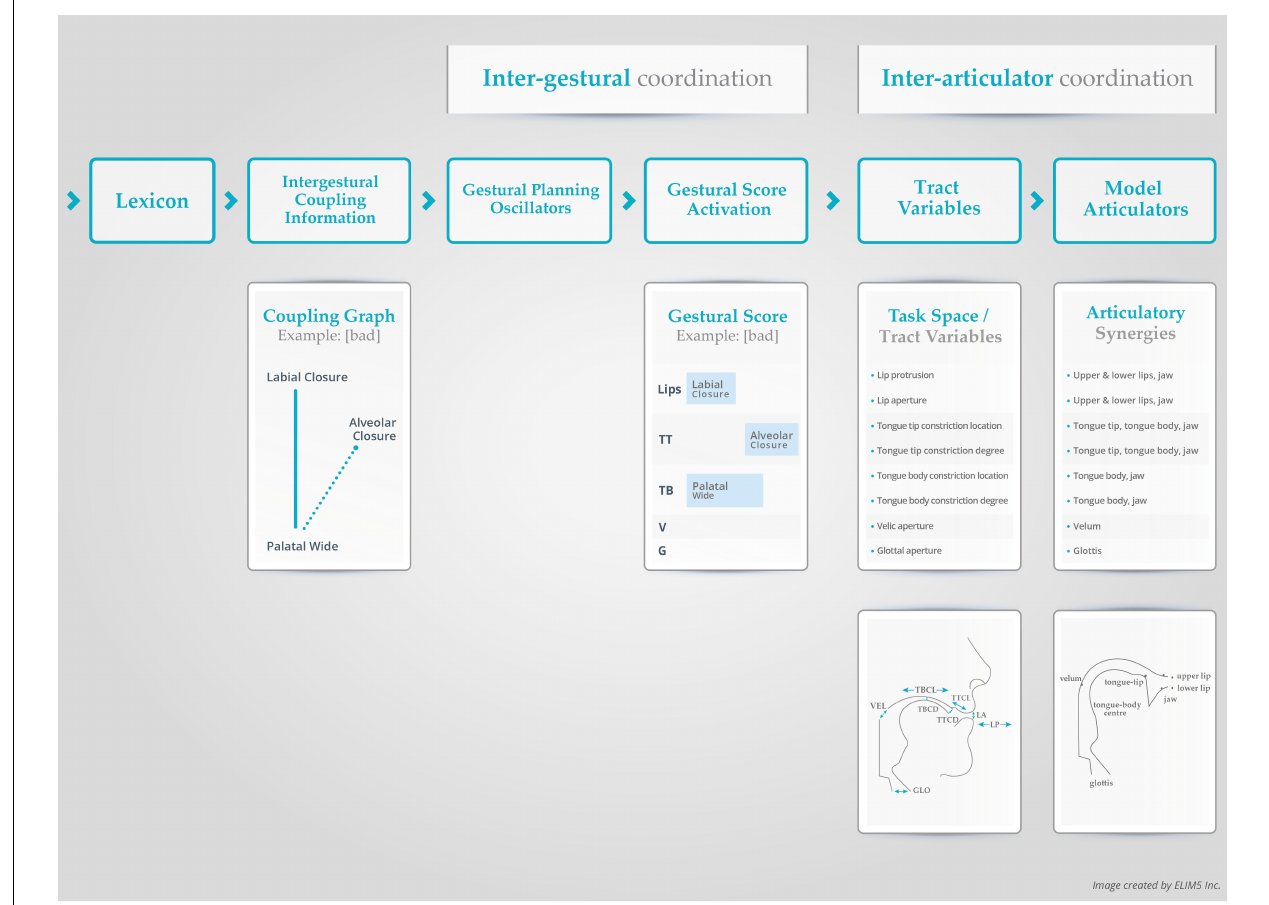
FIGURE 2 | A schematic representation of the AP model with key components (Nam and Saltzman, 2003; Goldstein et al., 2007). TT, tongue tip; TB, tongue body; CD, constriction degree; CL, constriction location; Vel (or V in panel 3), Velum; GLO (or G in panel 3), glottis; LA, lip aperture; LP, lip protrusion (see text for more